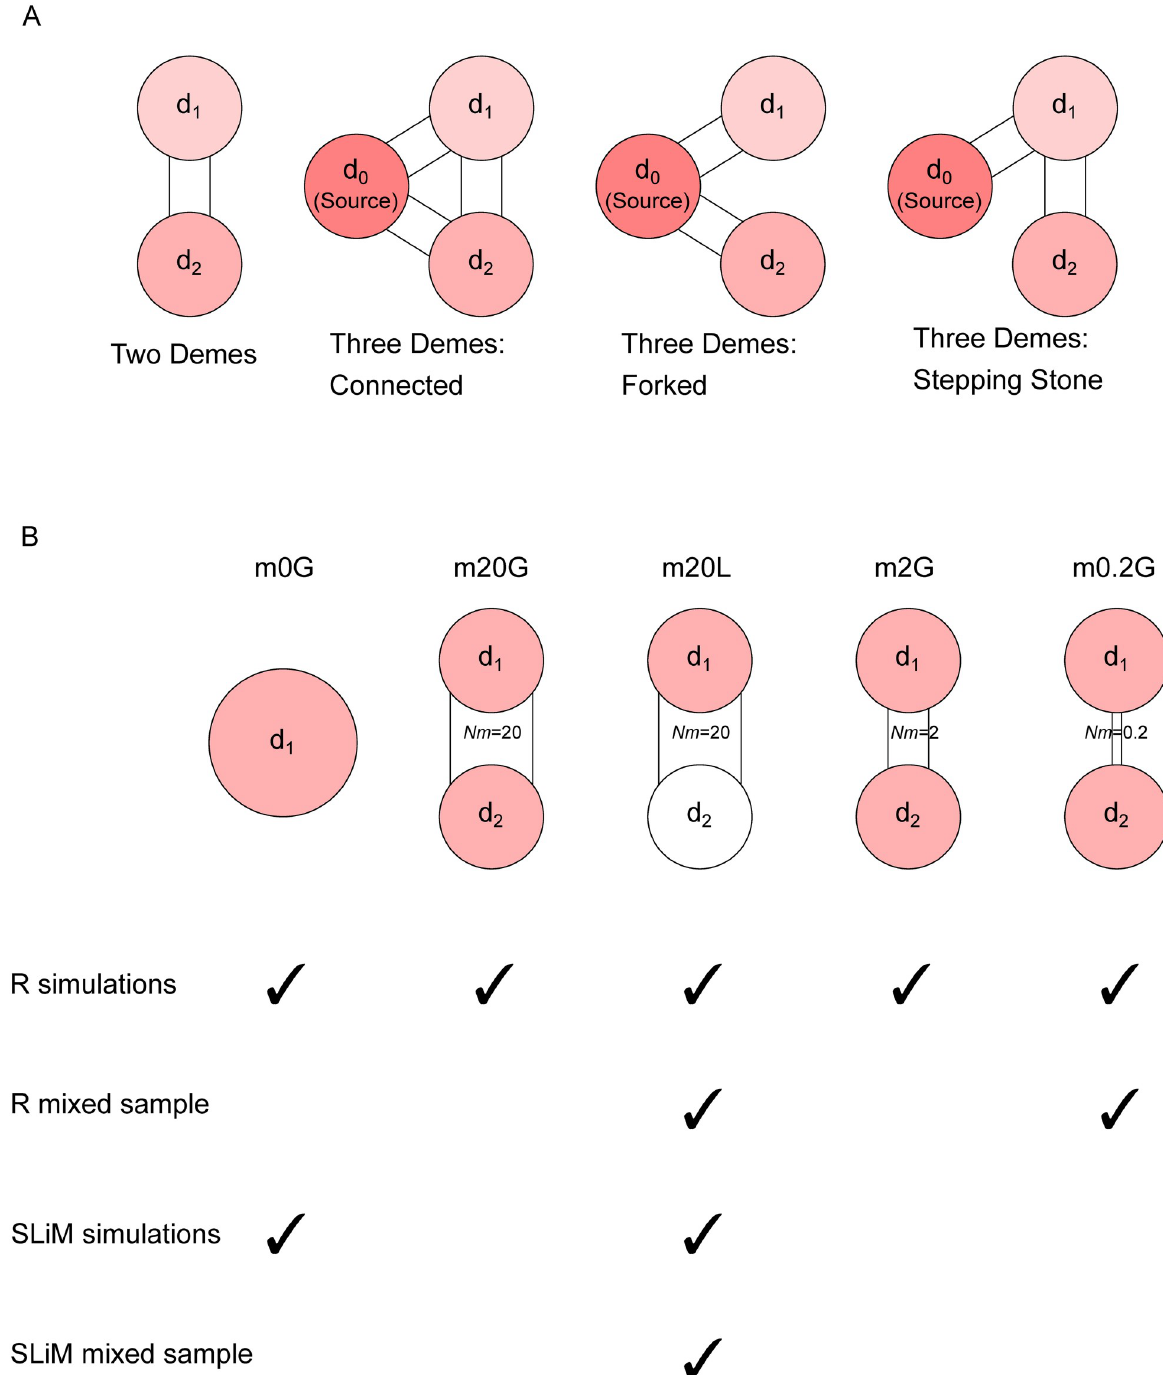
Fig 1. Schematic of evolutionary scenarios in this study. A: Possible demographies for single-site simulation; two-deme and three possibilities for three-deme. Different shades indicate that selection strength can be different between demes. Migration rates are identical between deme pairs and range from 0.02 to 200. B: Five scenarios explored in the full-locus simulation. Light red indicating selection in that deme and white indicates neutrality. Only m 20 L and m 0.2 G were analyzed for mixed-deme samples from R simulations (second row). Only m 0 G and m 20 L were simulated with SLiM (third row), of which only the latter were analyzed for mixed-deme samples from SLiM simulations (fourth row). Other scenarios listed in Table 2 were used for F analysis only. ST